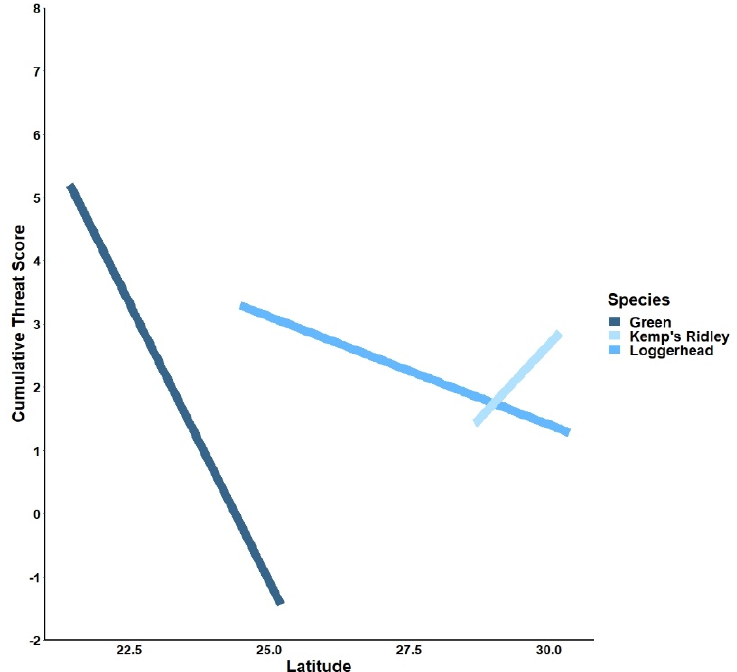
Figure 6. Interactive effects plot of latitude x species by the total score of all threats combined with Marine Protected Area (MPA) threat values removed (cumulative impact score) using standardized values. Standardizing threat scores reassigns values based on a mean of zero and standard deviation of one. PERMANOVA results show that removing MPA threat scores from our combined score still supports significantly lower threat values central to the Florida Keys National Marine Sanctuary and Dry Tortugas National Park for green turtles, but showed an increase in threat for loggerhead turtles (F 2,448 = 81.217, p = 0.001). Kemp’s ridleys also show lower cumulative threats in southern latitudes.